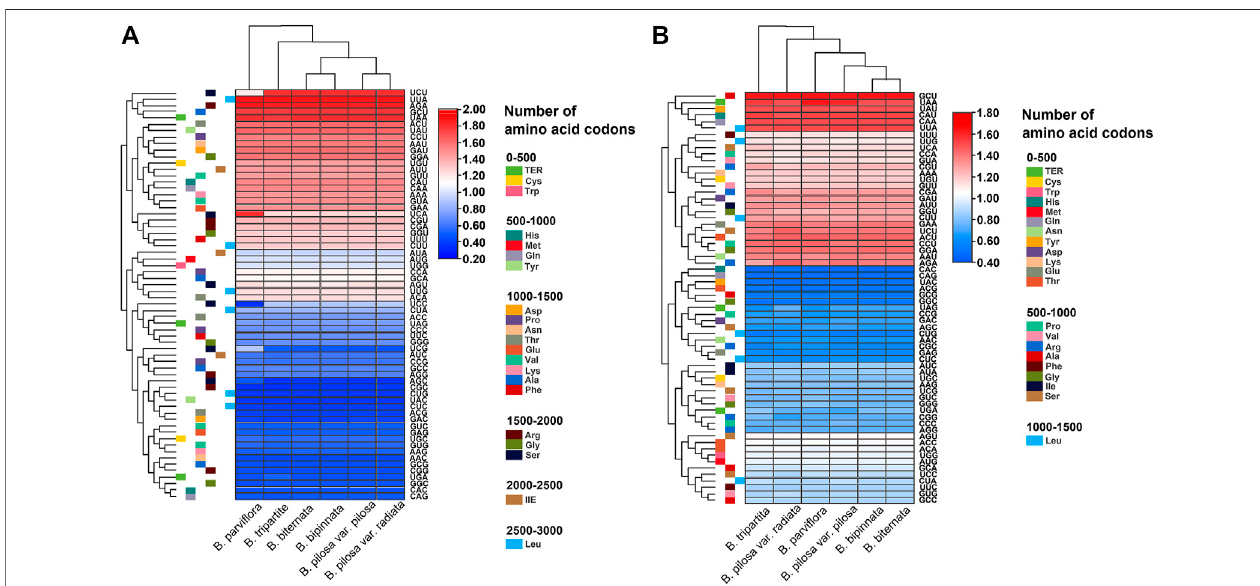
FIGURE 3 | Heat map of the RSCU values of the chloroplast (A) and mitochondrial (B) genomes of Bidens species.